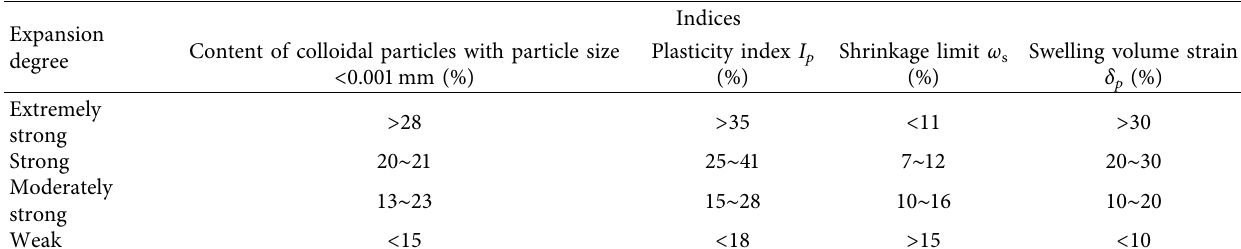
Table 3: American standard for expansion and shrinkage grades of expansive